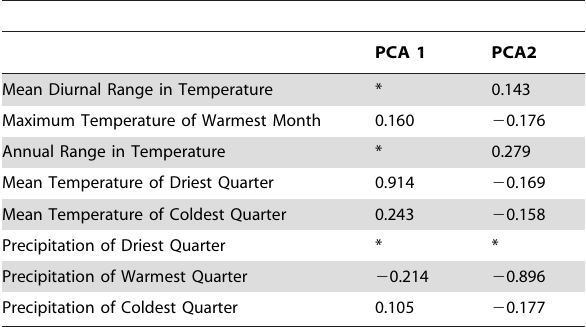
Table 1. Loadings on the first two principal components for the eight environmental variables used in the M AXENT